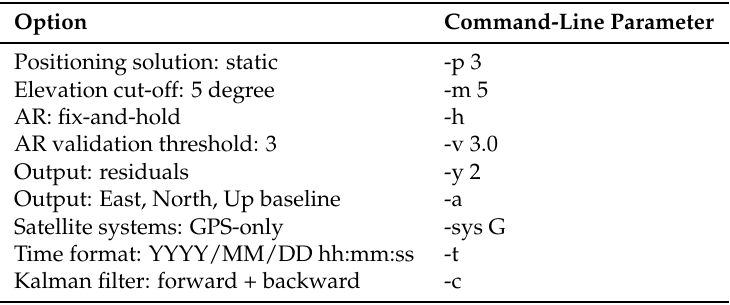
Table 2. RTKLIB RNX2RTKP command line